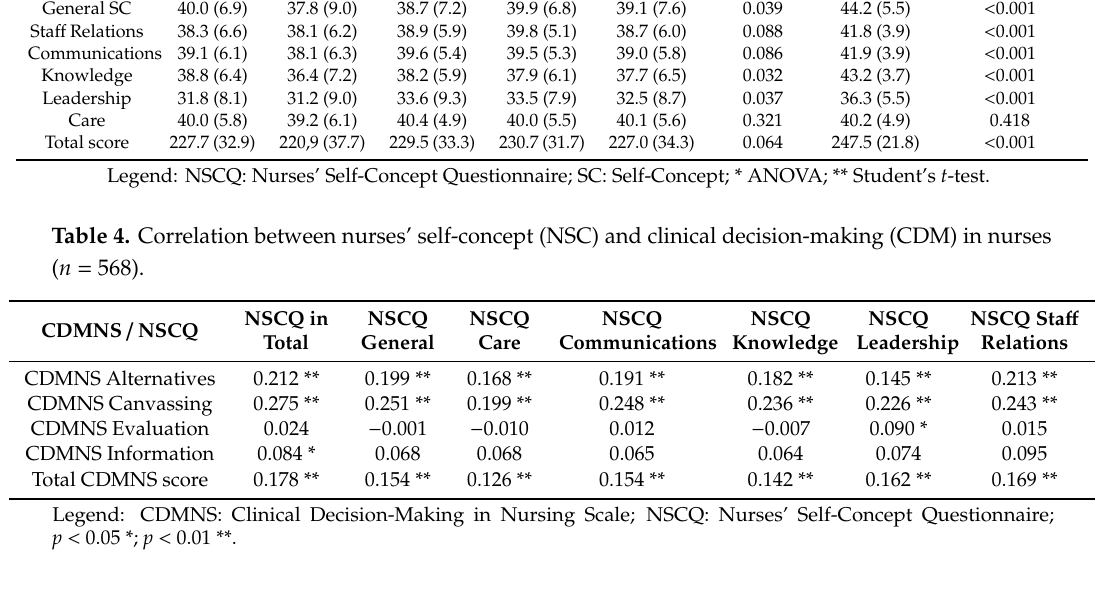
Table 5. Correlation between nurses’ self-concept (NSC) and clinical decision-making (CDM) in students ( n =